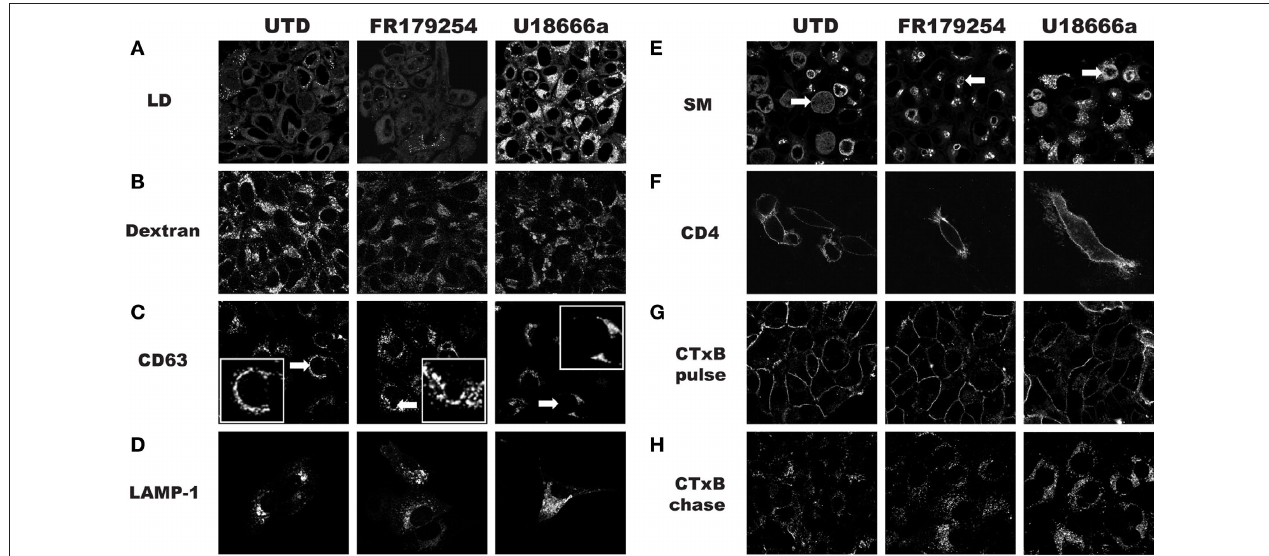
trafficking as measured by incorporation of fluorescent sphingomyelin (SM) in Golgi and chlamydiae. (F) Exocytic trafficking of glycoproteins as measured by localization of CD4 on the surface of transfected cells. (g,H) Analysis of retrograde trafficking using fluorescently tagged cholera toxin subunit B (CTxB) after pulse-chase labeling. Arrows within (C) and (e) indicate inclusions. Note the lack of significant staining in (C) (inset) and the presence of staining in (e) , which is contrast to a published study (Beatty, 2006).